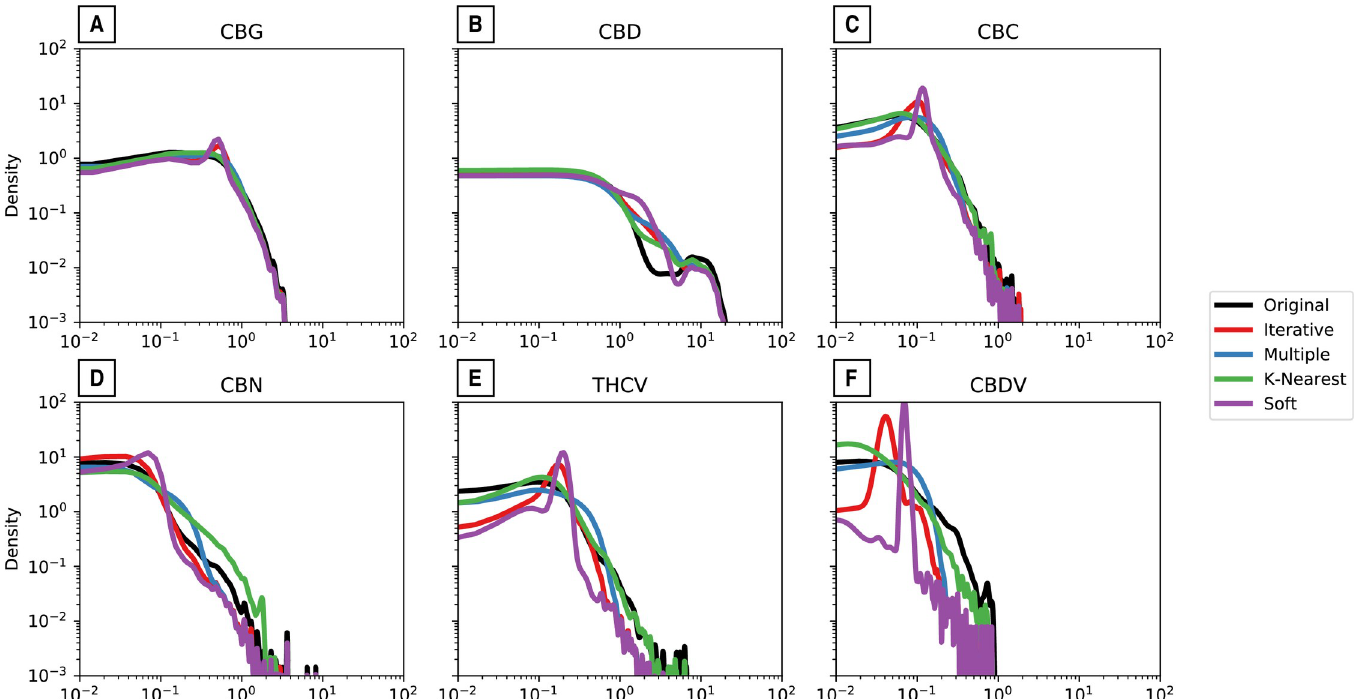
Fig 1. Density plots of original data and imputed values for each of the cannabinoids. The distribution of the observed values is in black, the iterative imputation in blue, the multiple imputation in red, the k-nearest neighbors in green, and the soft imputation in purple.